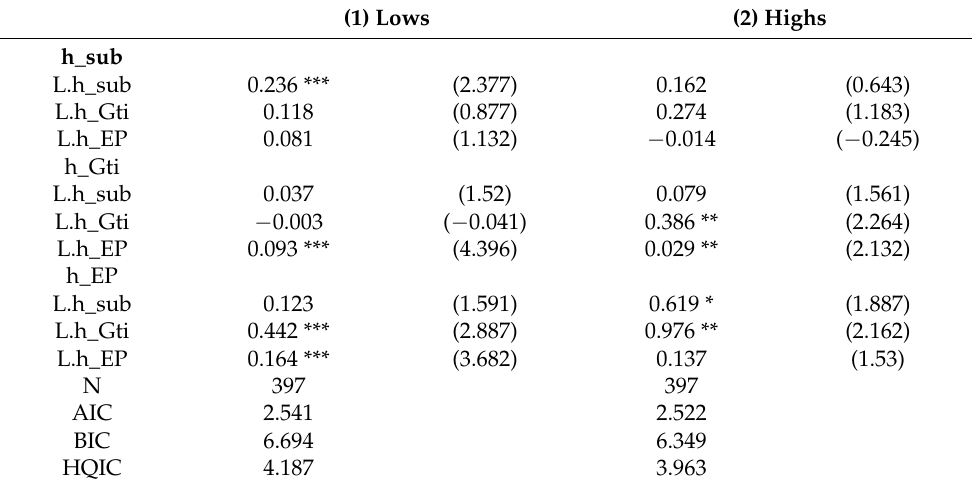
Table 5. Summary of GMM estimation results of PVAR model based on enterprise size